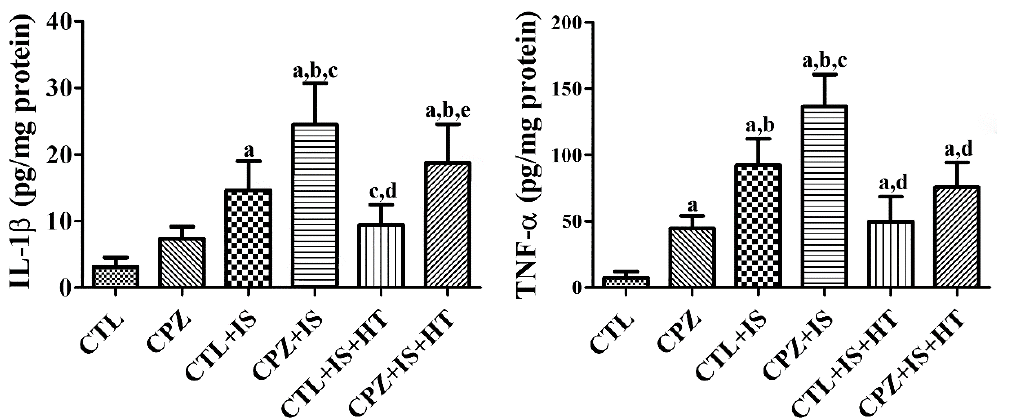
Figure 8. IL-1β and TNF-α levels in the gerbil hippocampal homogenates of the CTL, CPZ, CTL + IS, CPZ + IS, CTL + IS + HT, and CPZ + IS + HT groups 6 h after ischemia/reperfusion. Note that IL-1β and TNF-α levels were highest in the CPZ + IS group and lowest in the CTL + IS + HT group ( n = 5 per group, a p < 0.05, significantly different from the CTL group; b p < 0.05, significantly different from the CPZ group; c p < 0.05, significantly different from the CTL + IS group; d p < 0.05, significantly different from the CPZ + IS group; e p < 0.05, significantly different from the CTL + IS + HT group). Error bars indicate standard deviation.